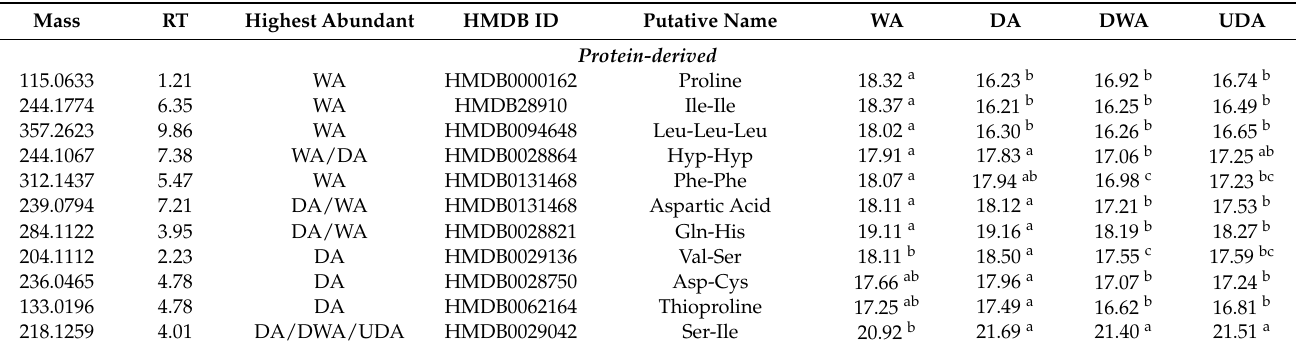
Table 4. Effect of different aging methods on the metabolomics profile of cull cow beef loins ( M. longis- simus lumborum ) after 28 days of aging. ( p -value < 0.05, FDR <